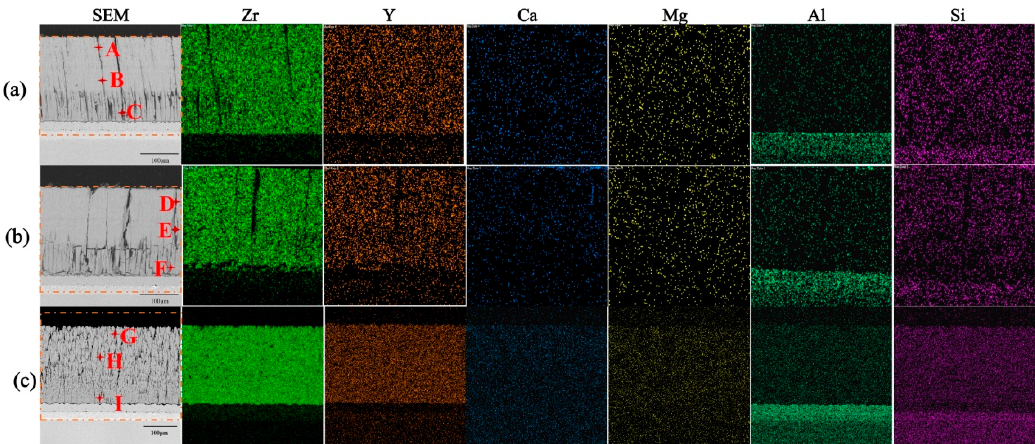
Figure 9. Cross-sectional EDS mapping of the residual coating after failure: ( a ) specimen 1; ( b ) specimen 2; and ( c ) specimen 3. Points A–C, D–F, G–I are the different thickness points within 8YSZ coating of the three specimens, and the corresponding EDS results are shown in Table 6. Table 6. Chemical compositions of the marked regions in Figure 9.